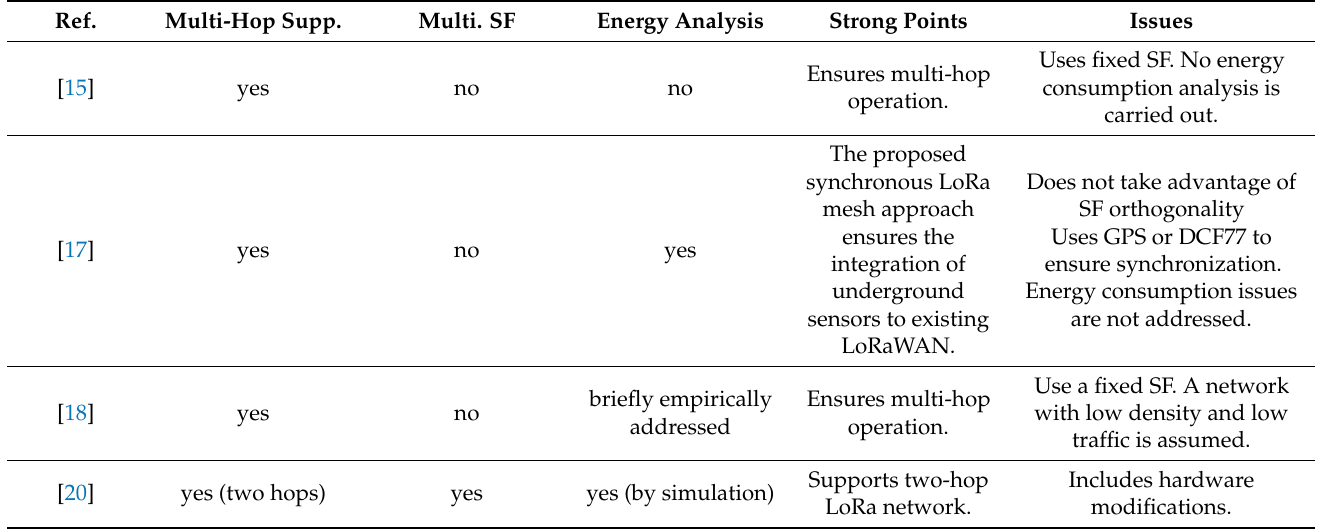
Figure 1. The advantages of using multiple SFs are twofold: (i) when a node is discon- nected within a blind spot, it may reach a relaying node using a lower SF, but it may need a higher one; and (ii) the use of multiple SFs increases the range of possibilities and the space for communication opportunities. Figure 2 shows a flowchart illustrating the different roles that nodes can play in a LoRa-based network that uses TSSFH to mitigate blind spots. When a node in the network sends a message to the GW, this node acts in a very similar way to a classical LoRaWAN node. The difference lies in the fact that it extends its reception windows to increase the probability of receiving beacon requests from nodes inside the blind spots. During the association process, nodes inside blind spots listen for transmissions from CNs or RNs to send them back beacon requests (after detecting transmissions from them). This occurs during the extension period, just when a CN (or a RN) finishes sending a message and after receiving its respective acknowledgement from a GW. Once a beacon request is re- ceived by a CN, it switches its role to that of a relay node activating TSSFH, which peri- odically opens extra listening windows for relaying purposes. RNs relay data packets